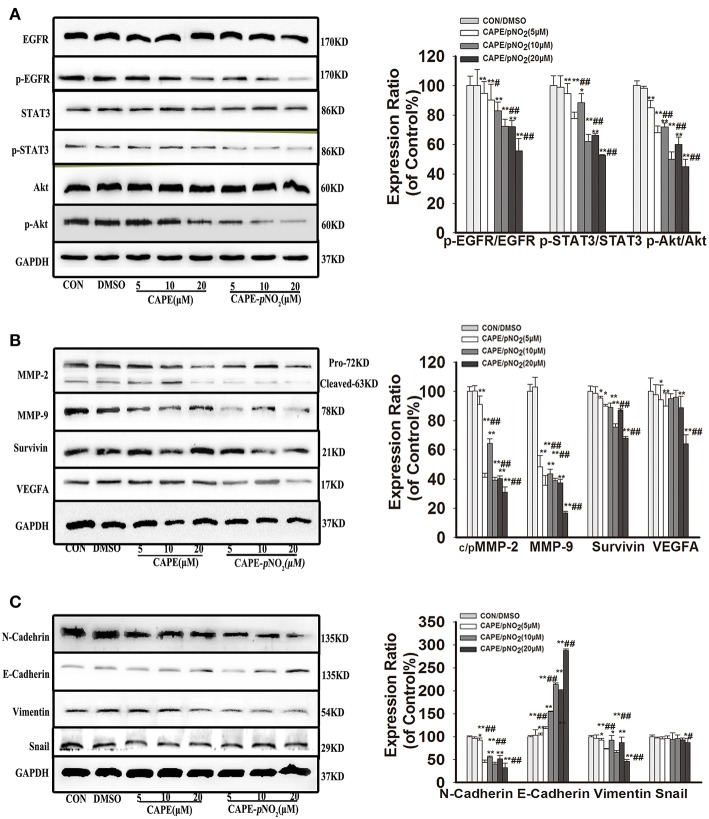
The EGFR signaling pathway and EMT progression were suppressed by CAPE-pNO2 in MDA-MB-231 cells. Cells were incubated with CAPE or CAPE-pNO2 (5, 10, and 20 μM) for 24 h, and protein expression levels were analyzed by a Western blot assay and quantified by densitometric analysis. (A) The protein expression levels of EGFR, p-EGFR, STAT3, p-STAT3, Akt, and p-Akt. (B) The protein expression levels of MMP-2, MMP-9, Survivin, and VEGFA. (C) EMT-related protein expression. The bar graphs show the relative protein expression levels. Values represent the mean ± SD from three independent experiments; *p < 0.05, **p < 0.01: DMSO, CAPE and CAPE-pNO2 compared with the control; #p < 0.05, ##p < 0.01: CAPE-pNO2 compared with CAPE at the same concentration.